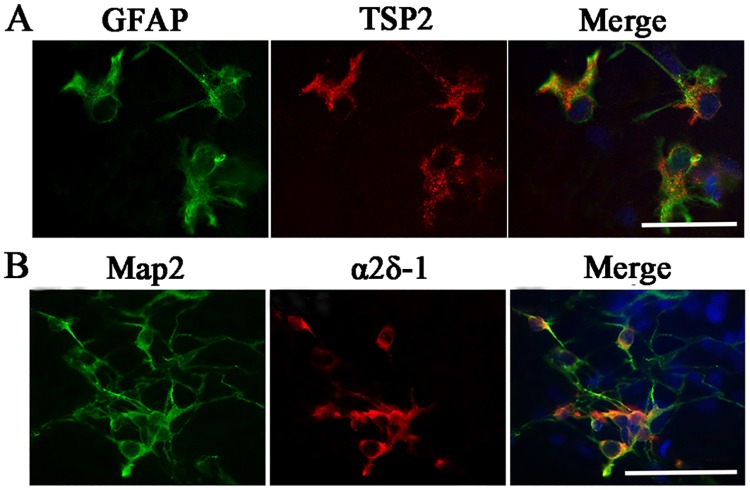
Immunofluorescence for the localization of TSP2 and α2δ-1.(A) Localization of TSP2 was identified by TSP2/GFAP co-staining. (B) Localization of α2δ-1 was identified by α2δ-1/Map2 co-staining. Scale bar = 50 μm.